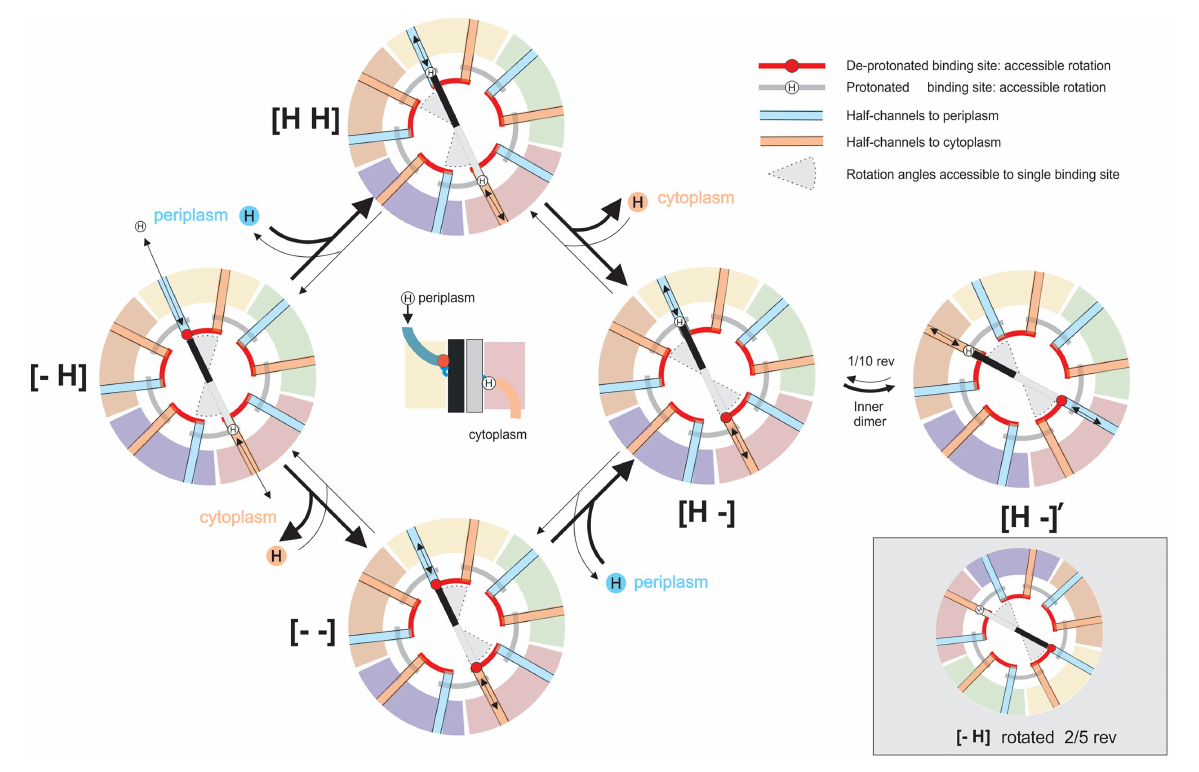
FIGURE 6 A model for the mechanistic basis for the function of 5:2 rotary motors. Schematic cross-sections of a 5:2 rotary motor in a membrane slice containing the proton-binding sites on the inner dimer. Different outer subunits are shown as arcs, distinguished by color, inner subunits are shown as black and gray bars. Deprotonated sites are negatively charged (red circles), protonated sites are neutral (“H”). “Half-channels” linking sites to the periplasm (blue) or cytoplasm (orange) are shown as colored radial lines. The location of half-channels relative to the boundaries between outer subunits is drawn from the MotAB structure (Santiveri et al., 2020), but it does not affect the mechanism and is speculative and illustrative only. Black arrows indicate transitions in the mechanochemical cycle, accessible from each state. Red and gray arcs indicate angles that a binding site can occupy when de-protonated or protonated, respectively. The central image shows a side view of state [ − H], illustrating half- channels. In state [ − H], the charged “black” binding site can bind a proton from the periplasm, and the “grey” site has a proton bound which can be released into the cytoplasm. Either of these transitions locks dimer rotation due to the constraints on individual binding sites (states [H H] or [ − − ]). After both transitions are completed the inner dimer is free to rotate counterclockwise (states [H -], [H -]’). States [ − H] and [H -]’ are equivalent: rotation of the entire complex and exchange of nominally identical subunits maps one onto the other (bottom right). The cycle is reversible, but it is biased by the PMF, which drives protons from the periplasm to the